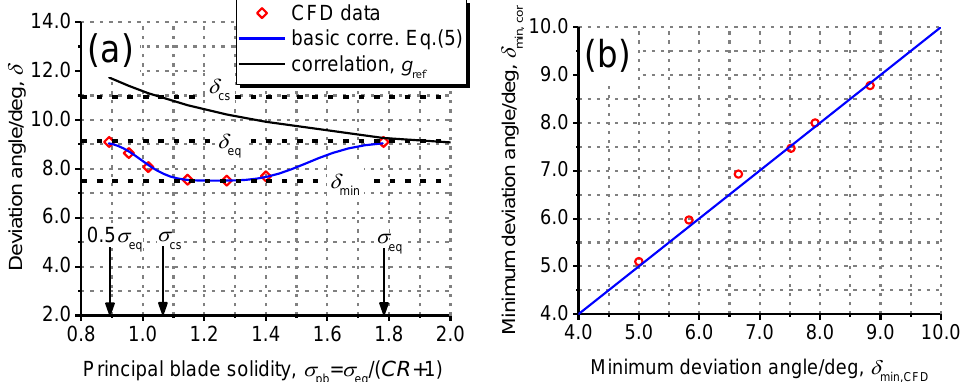
Figure 11. ( a ) Re-illustration of Figure 8b with solidity of PBs and ( b ) comparison between model predicted δ min,cor and CFD calculated δ min,CFD .